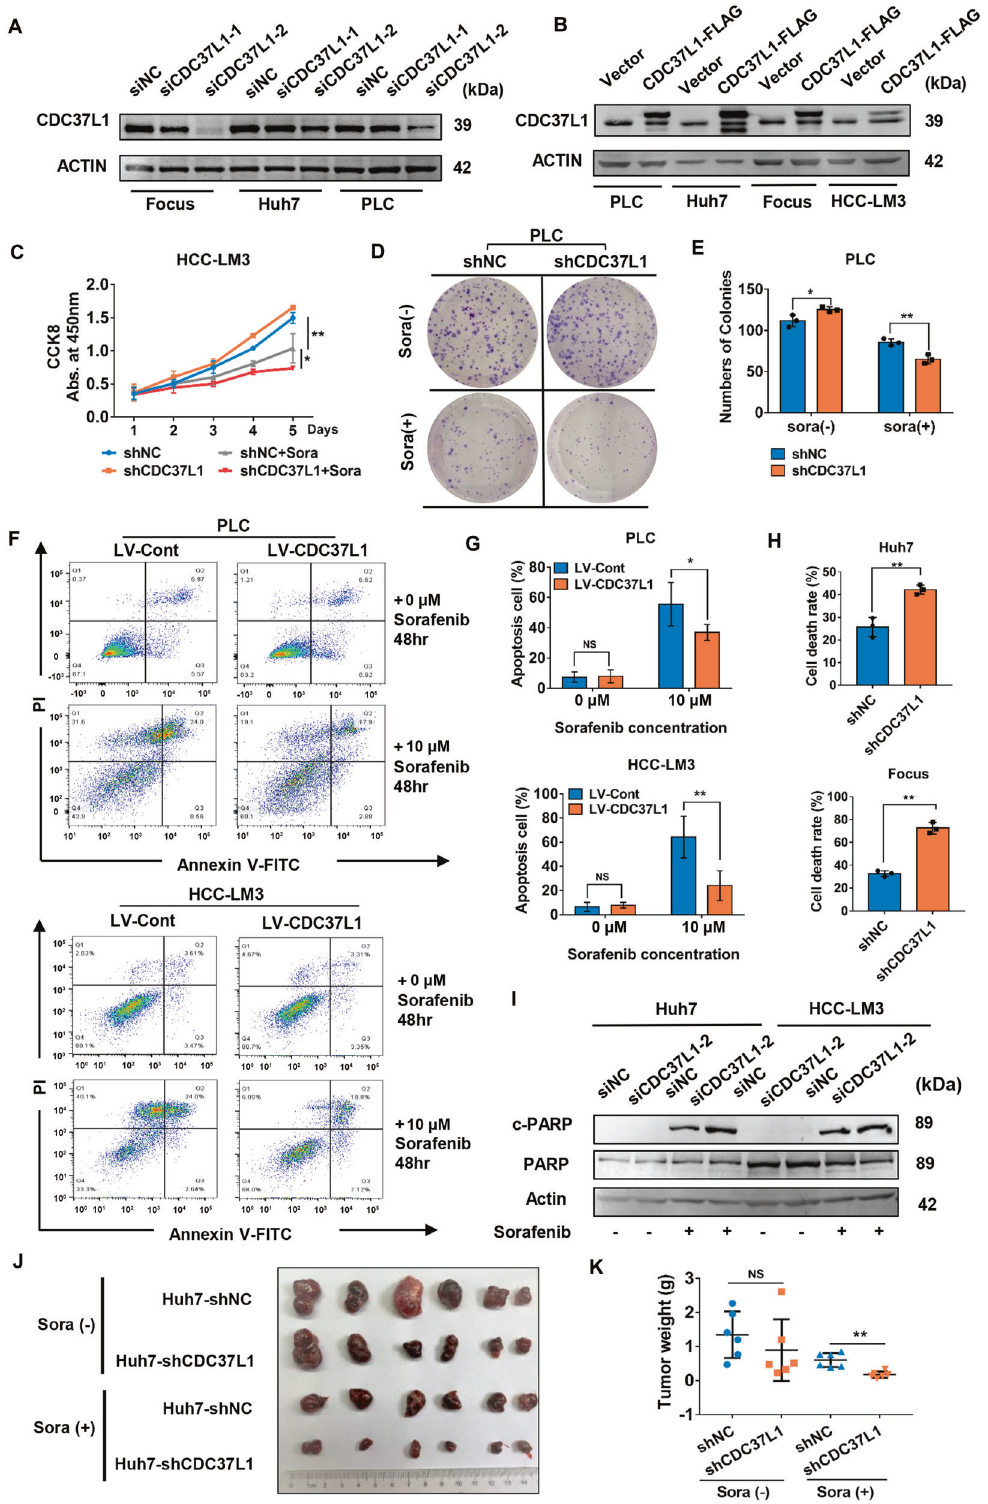
proliferation, migration, and invasion, and accelerating apoptosis or necroptosis [30 – 32]. Moreover, the association between miR- 15a and immune response was found in recent years [33, 34]. Previous study also implicated that miR-15a decreased myeloma cell growth and survival by inhibiting the G1 / S transition.